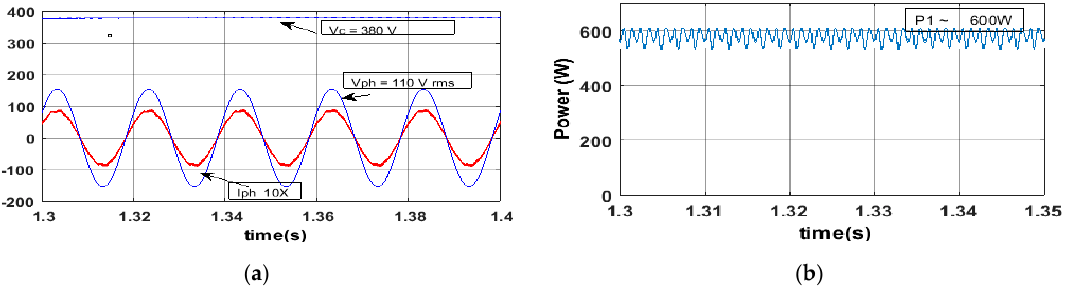
Table 2. Simulation Parameter.